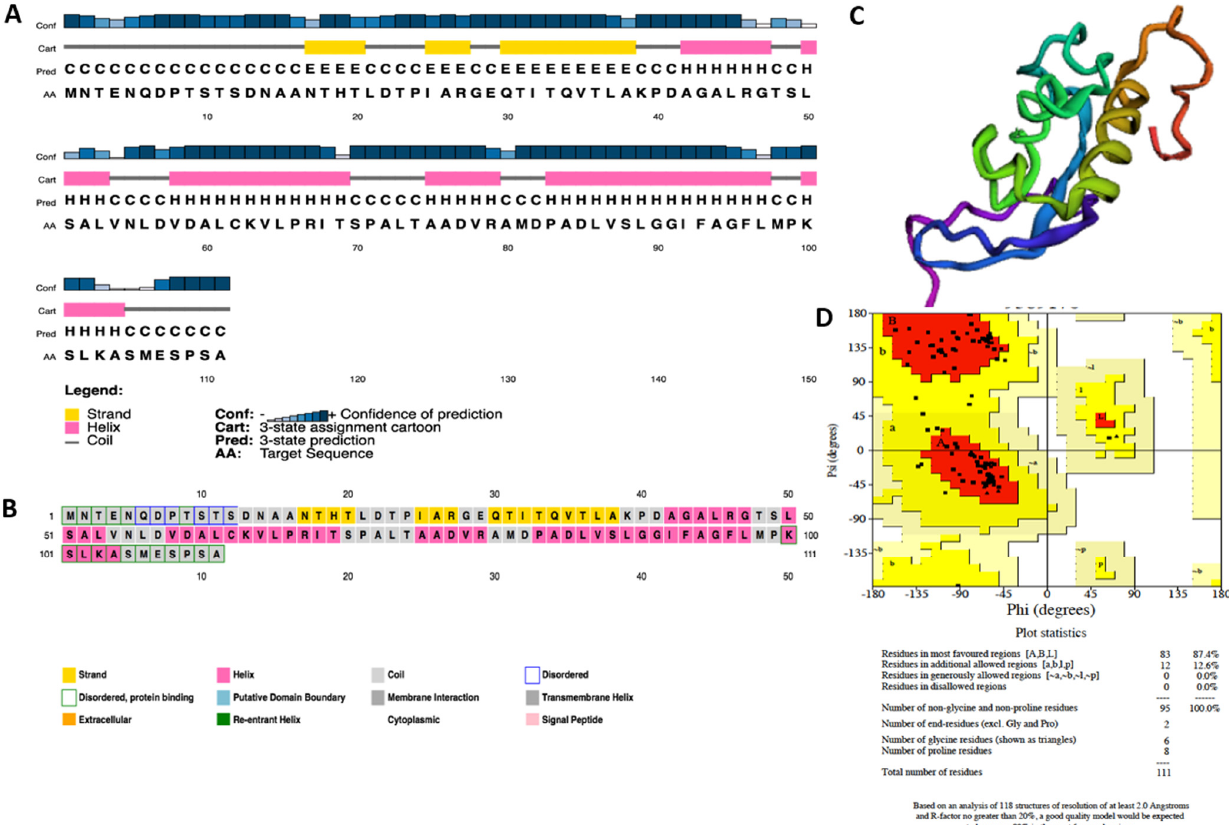
Figure 5. ( A ) Prediction of secondary structure of Bg_9562 using PSIPRED 4.0 work bench ( B ) Anno- tation grid showing the structure and function of each residue of Bg_9562 protein using PSIPRED 4.0. ( C ) 3D structure model of Bg_9562 developed using Robetta ( D ) Validation of 3D structure model using Ramachandran